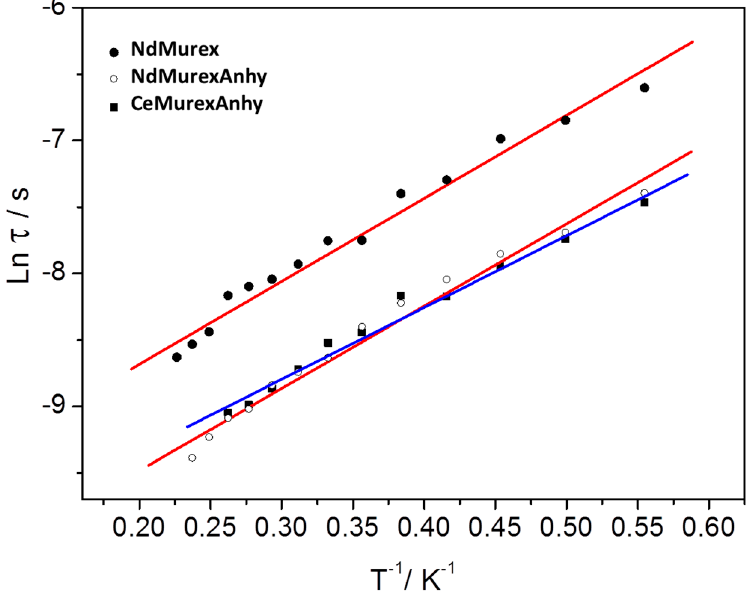
Figure 7. Arrhenius plot with best fits for NdMurex (full circles), NdMurexAnhy (empty circles), and CemurexAnhy (full squares).